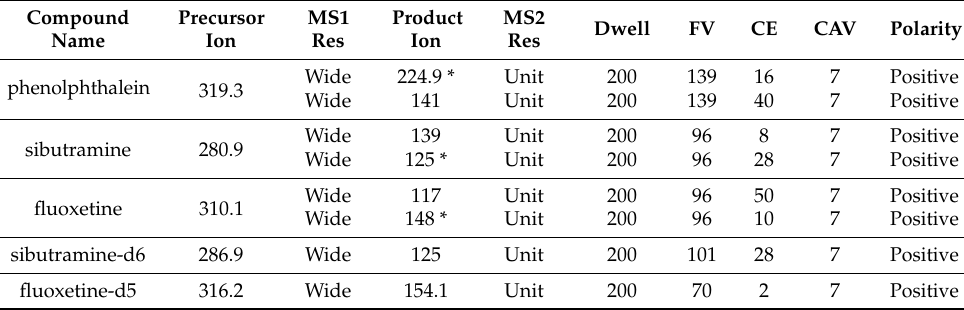
Table 7. Acquisition